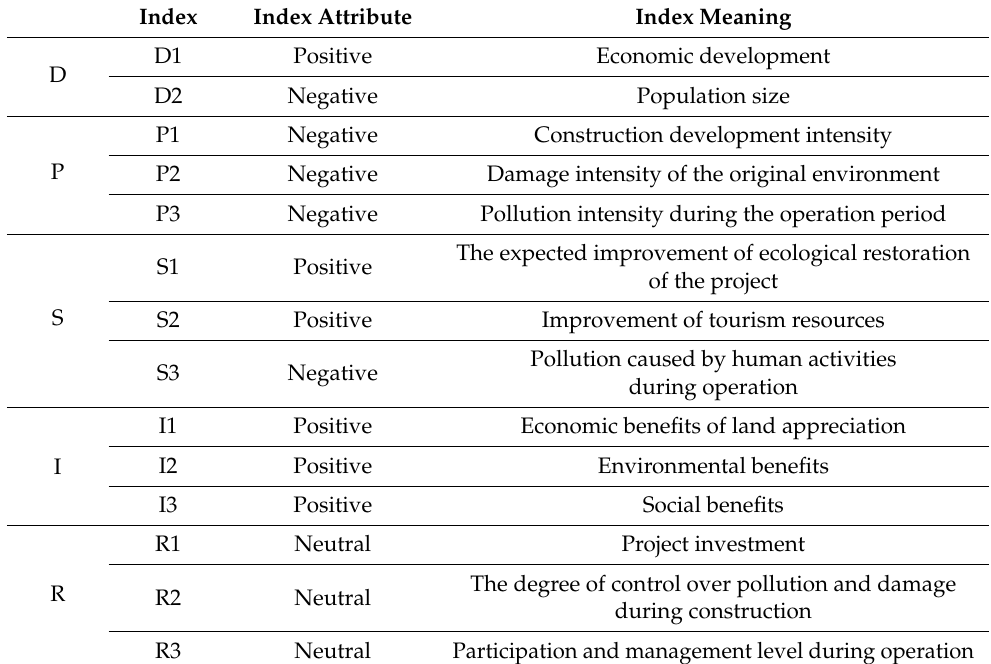
Comprehensive environmental impact evaluation indicators for ecological restora- tion